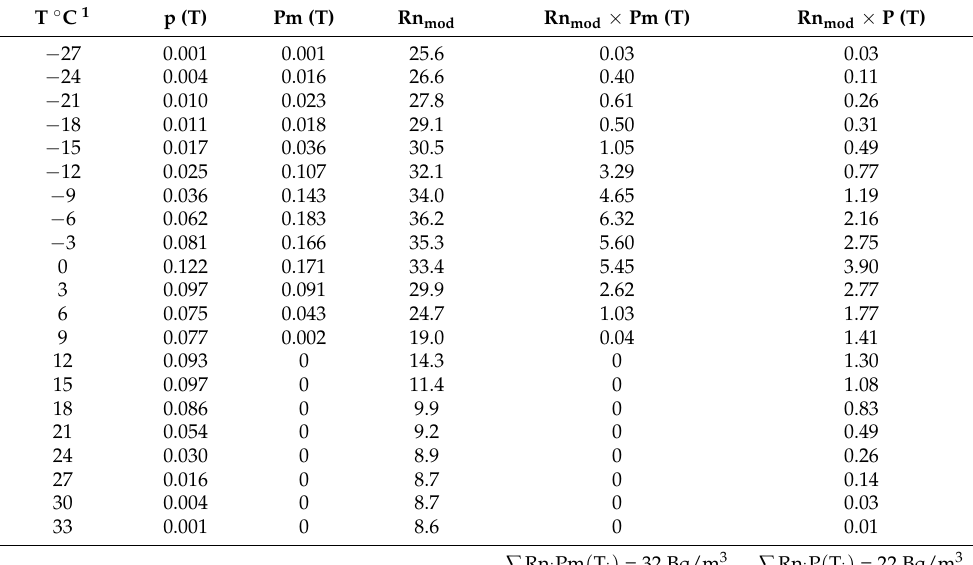
Table 9. Calculation of the average annual radon concentration in a sample of buildings in Nizhny